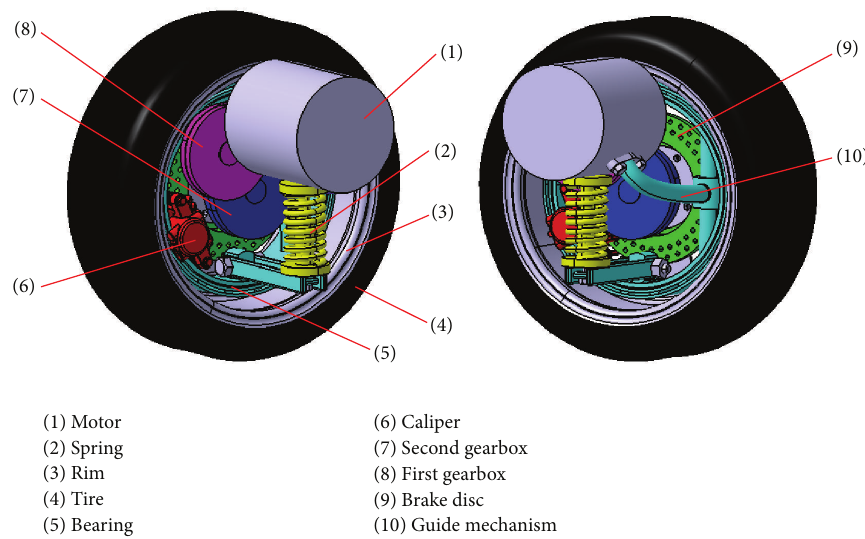
Figure 4: E-DVA module